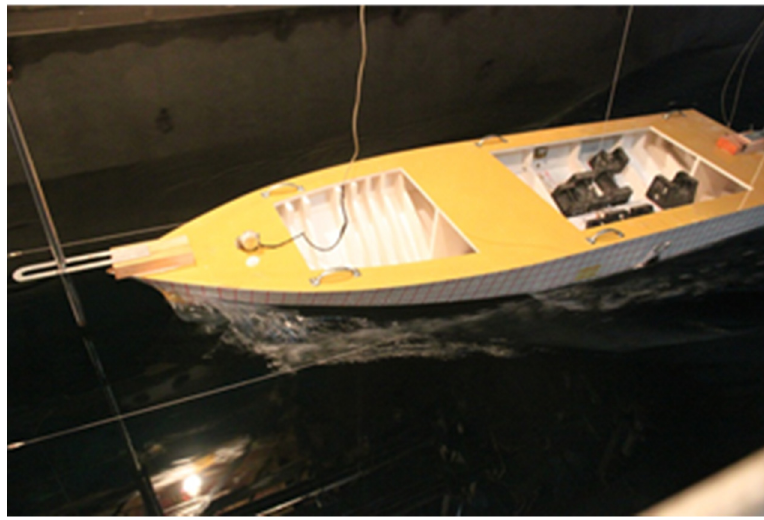
Figure 4. Snapshot of the model.